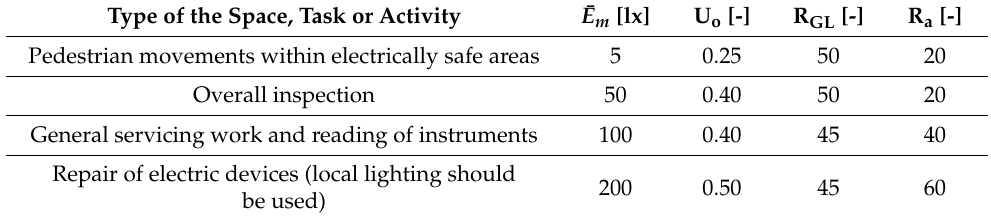
Table 1. Photometric requirements for specific power- and electricity-related outdoor workplaces [1]. Type of the Space, Task or